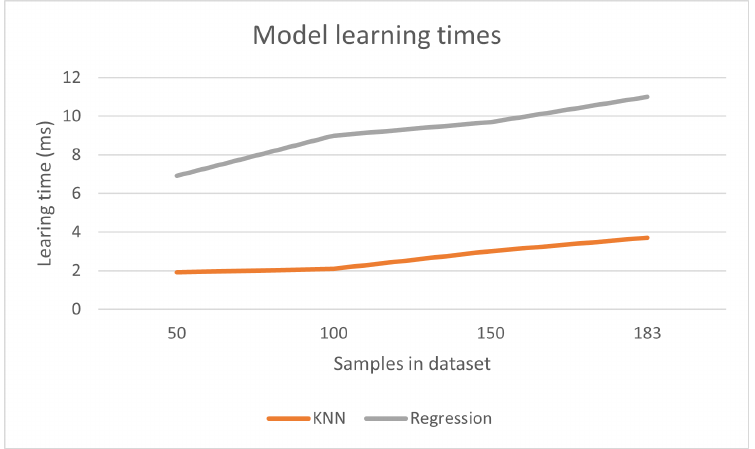
Figure 16. Learning times of classification